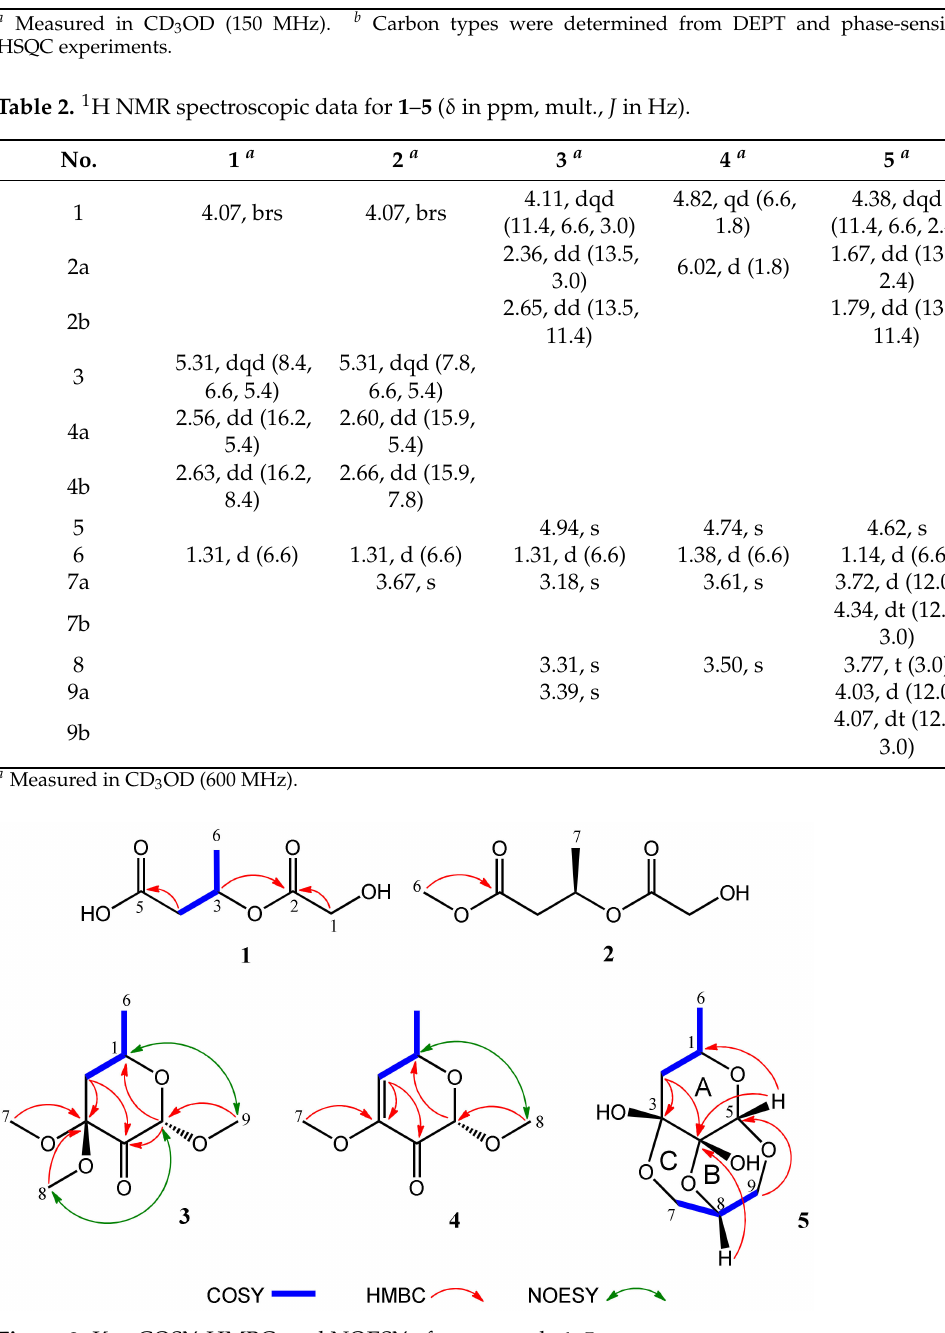
Figure 2. Key COSY, HMBC, and NOESY of compounds 1 – 5